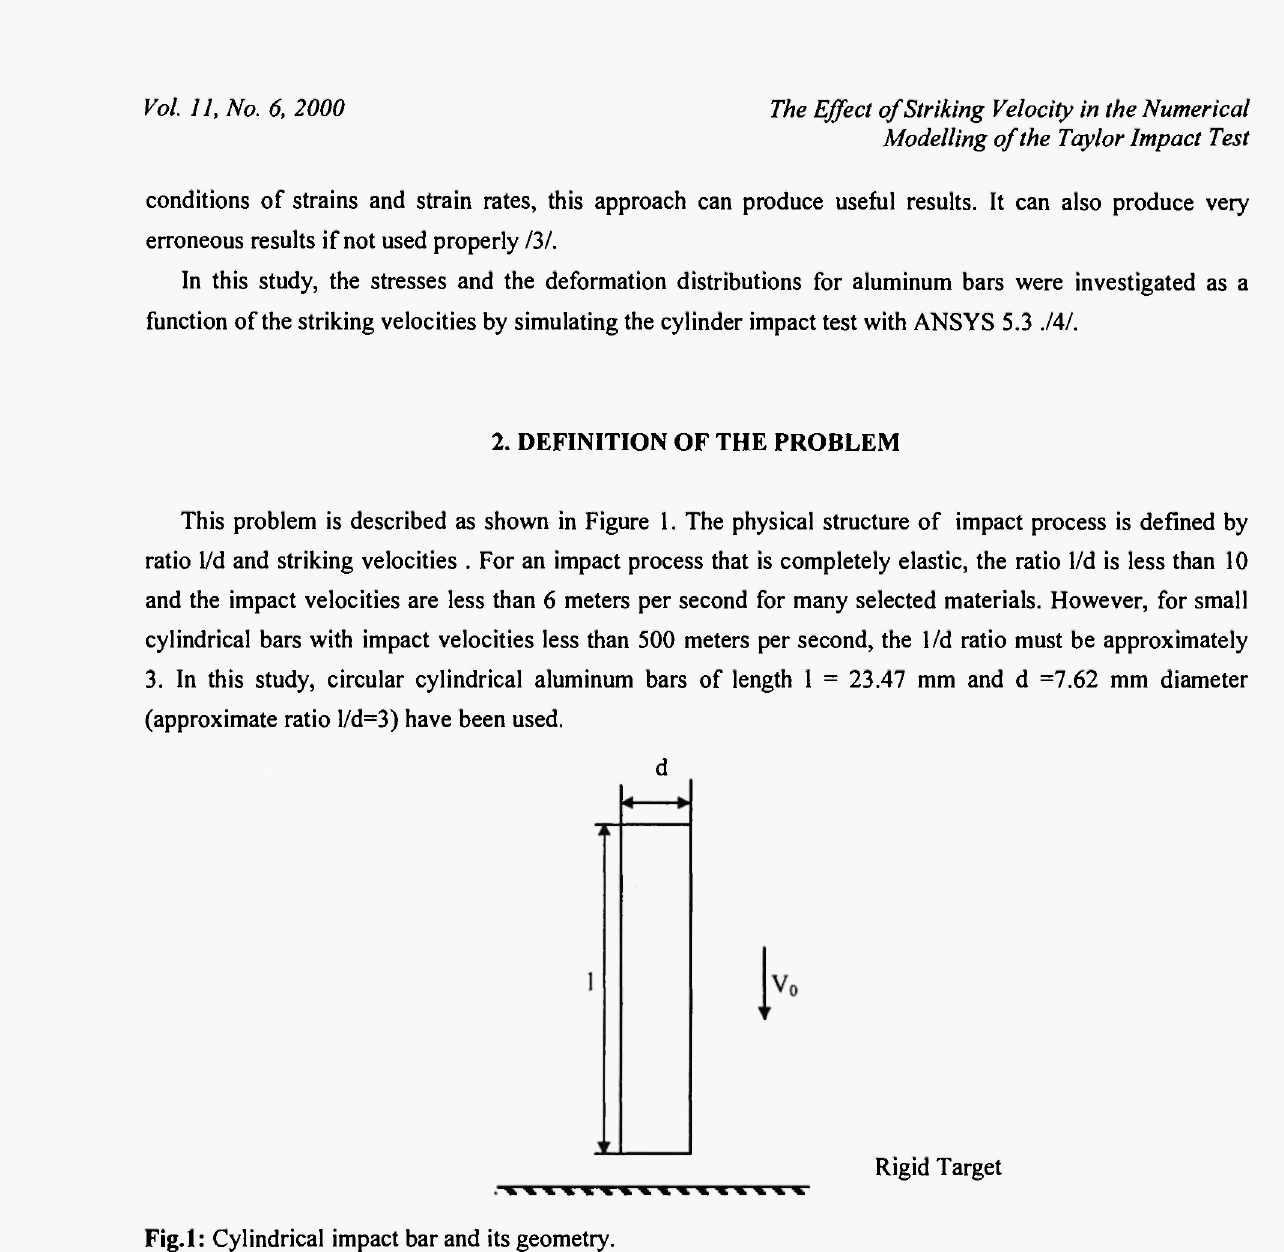
Fig.l: Cylindrical impact bar and its geometry.